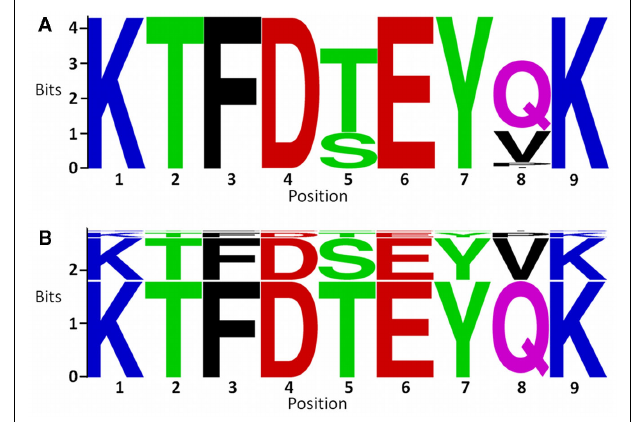
FIGURE 4 | (A) Sequence logo plot of the residues in the block starting at position 388 of the MSA of NS3 protein sequences.The sequence logo was generated usingWebLogo (http://weblogo.berkeley.edu/). (B) Shows a peptide block logo of the peptides in the same block.The block logo was generated locally using the Block Logo tool.The colors of the amino acids correspond to their chemical properties: polar amino acids (G, S,T,Y, C, Q, and N) are shown in green, basic amino acids (K, R, and H) are shown in blue, acidic amino acids (D and E) are shown in red, and hydrophobic amino acids (A,V, L, I, P,W, F, and M) are shown in